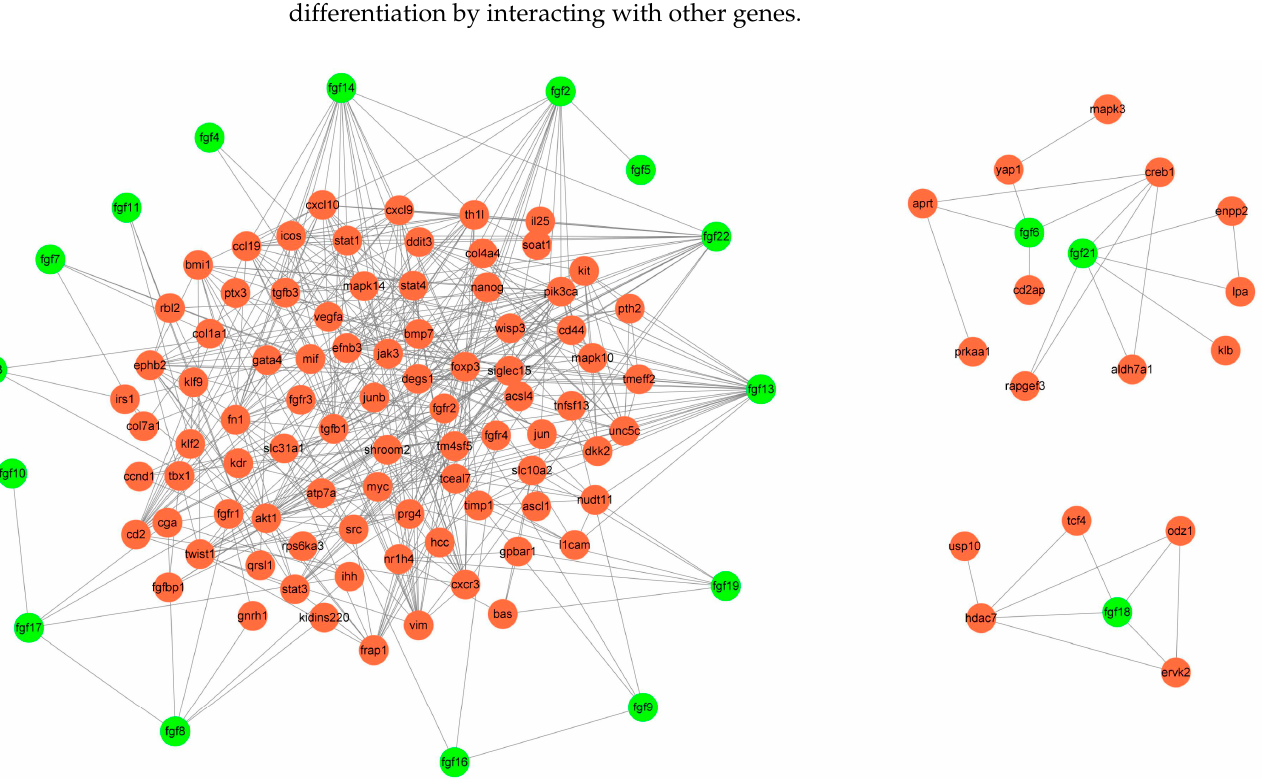
Figure 9. Expression assay of FGFRs genes. ( A ) Detection of FGFRs gene expression pro fi le in dif- ferent tissues of ca tt le. ( B ) Detection of FGFRs gene expression pro fi le during bovine adipocyte dif- ferentiation. Compared with the control, “*” means a signi fi cant di ff erence ( p < 0.05), “**” means an extremely signi fi cant di ff erence ( p < 0.01).